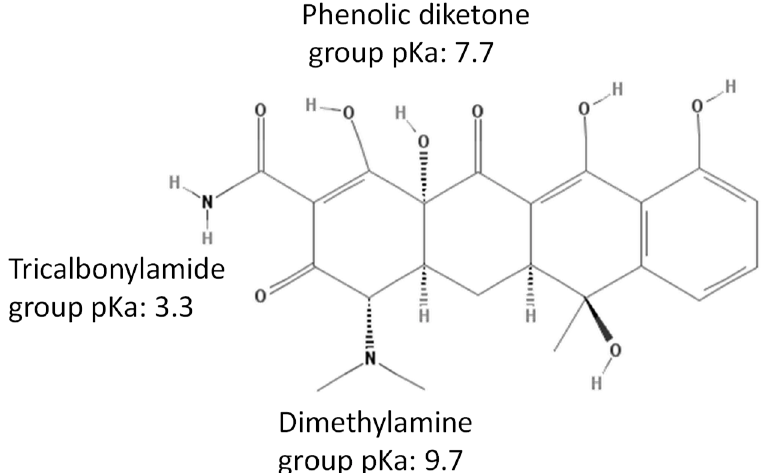
Figure 1. Structure of the TC molecule and proton dissociation constants for acid–base active groups, after [16,19]. Image Source: PubChem, URL: https://pubchem.ncbi.nlm.nih.gov. Data deposited in or computed by PubChem.